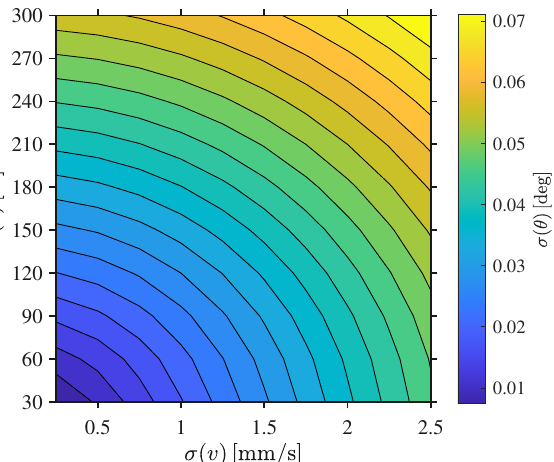
Figure 13. Effects of position and velocity errors on the breathing angle (three months’ propagation).